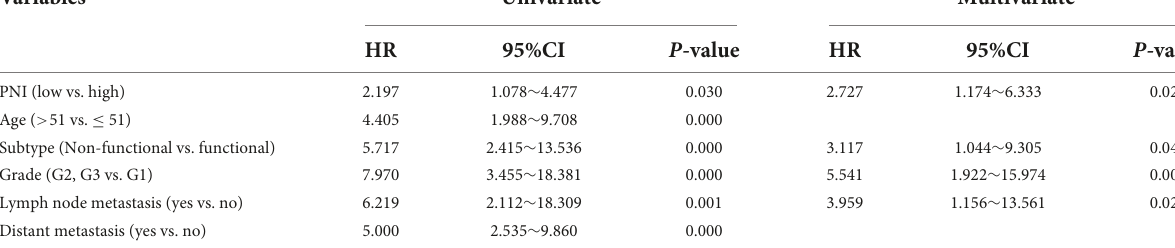
TABLE 4 Univariate and multivariate analysis of PFS in patients with pNENs. Variables